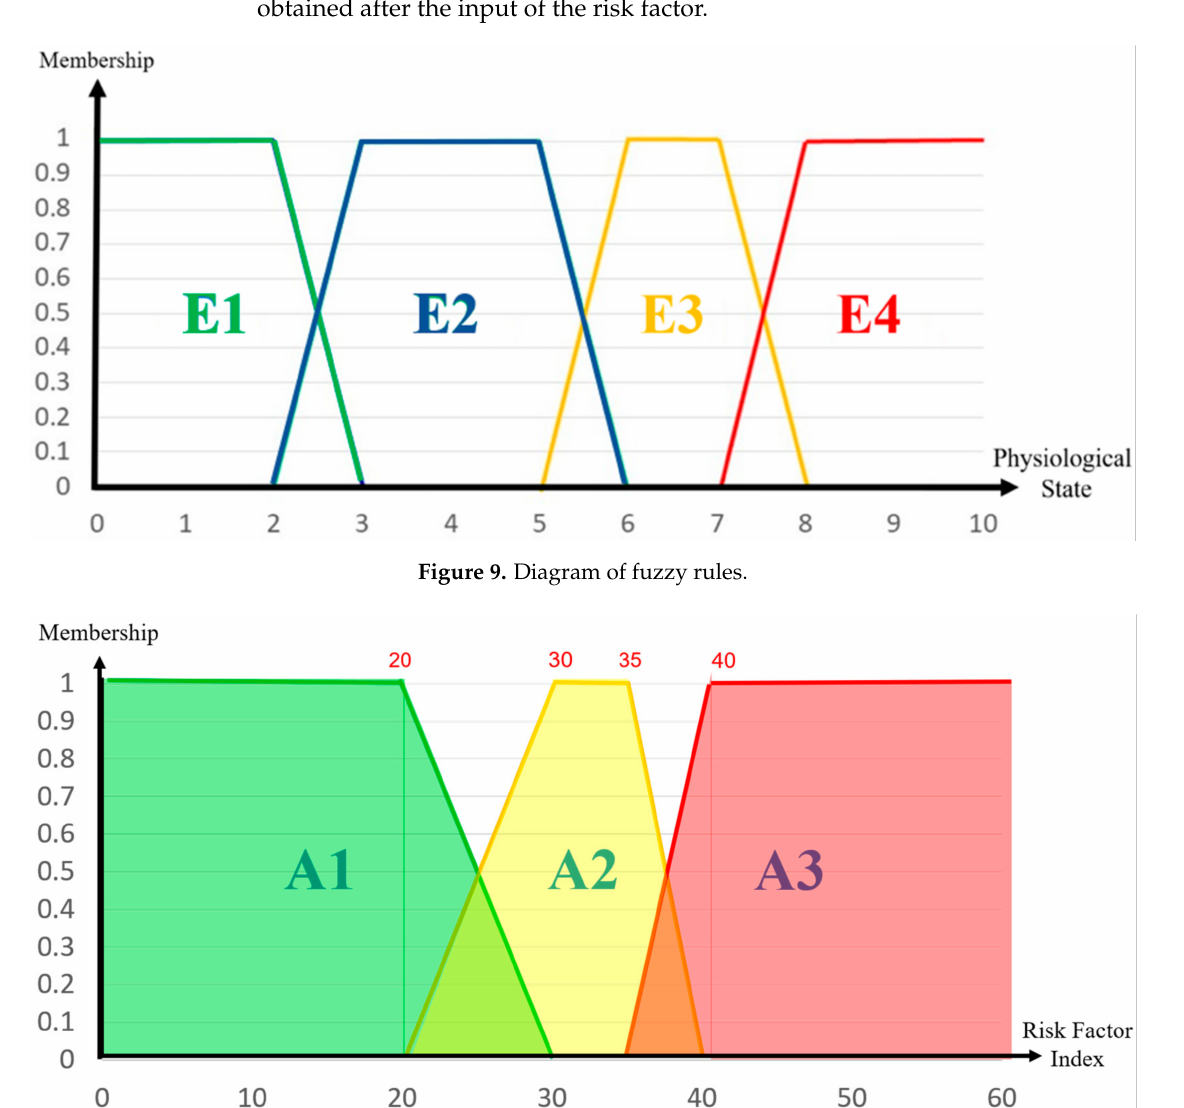
Figure 10. Coefficient of the fuzzy